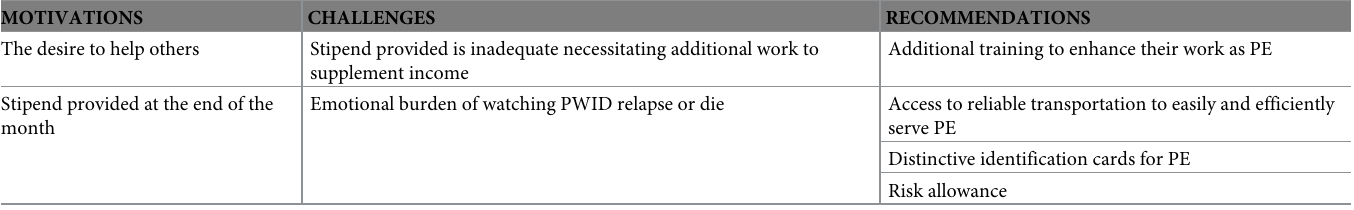
Table 3. Summary of motivations, challenges and recommendations for additional services and resources for PE.